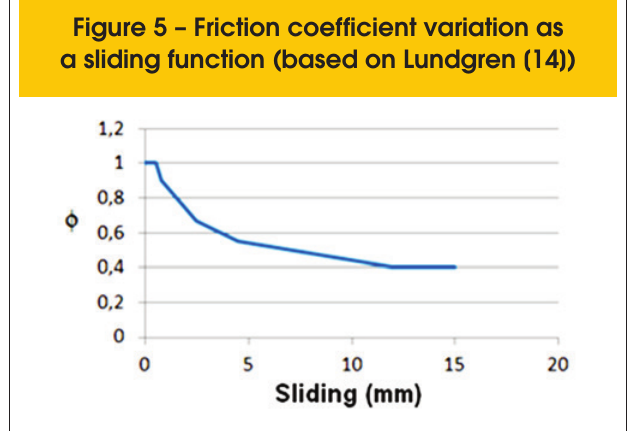
Figure 5 – Friction coefficient variation as a sliding function (based on Lundgren